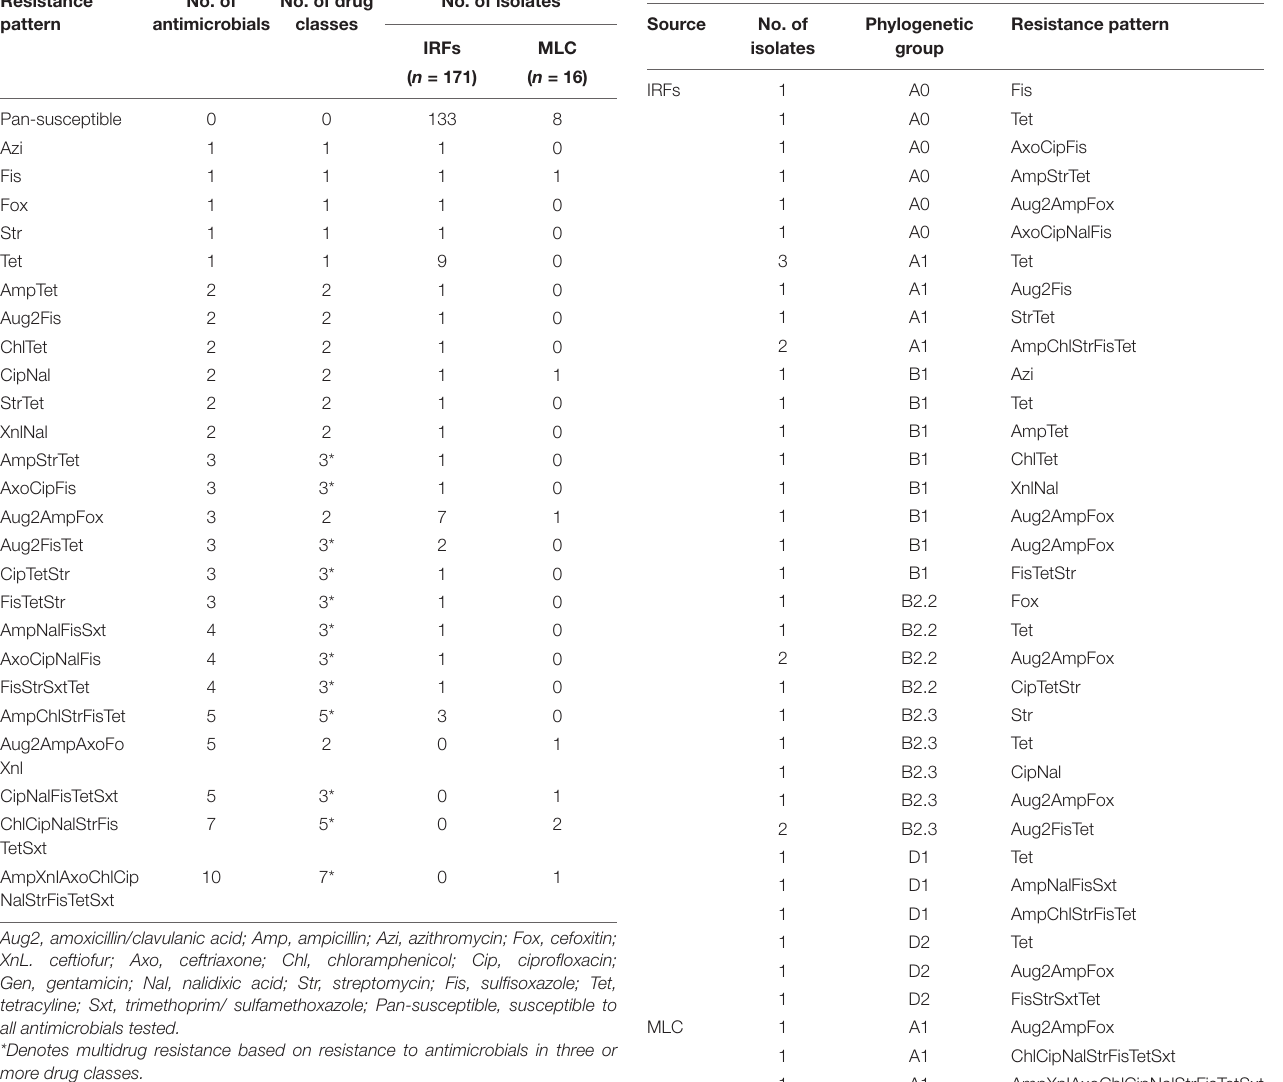
TABLE 6 | The distribution of resistant E. coli isolates from the irrigation return flows (IRFs) and background canal site (MLC) by phylogroup and resistance